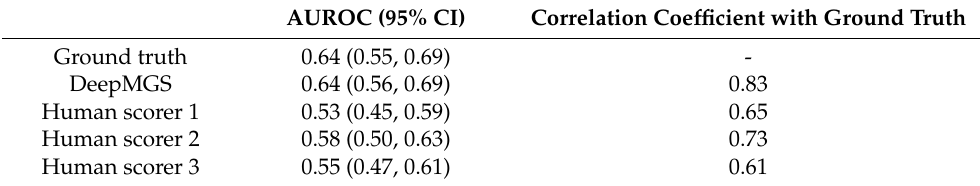
Table 4. Comparison of the performance of DeepMGS and three apprentice human scorers in distinguishing NTG and saline conditions with ground truth by linear regression